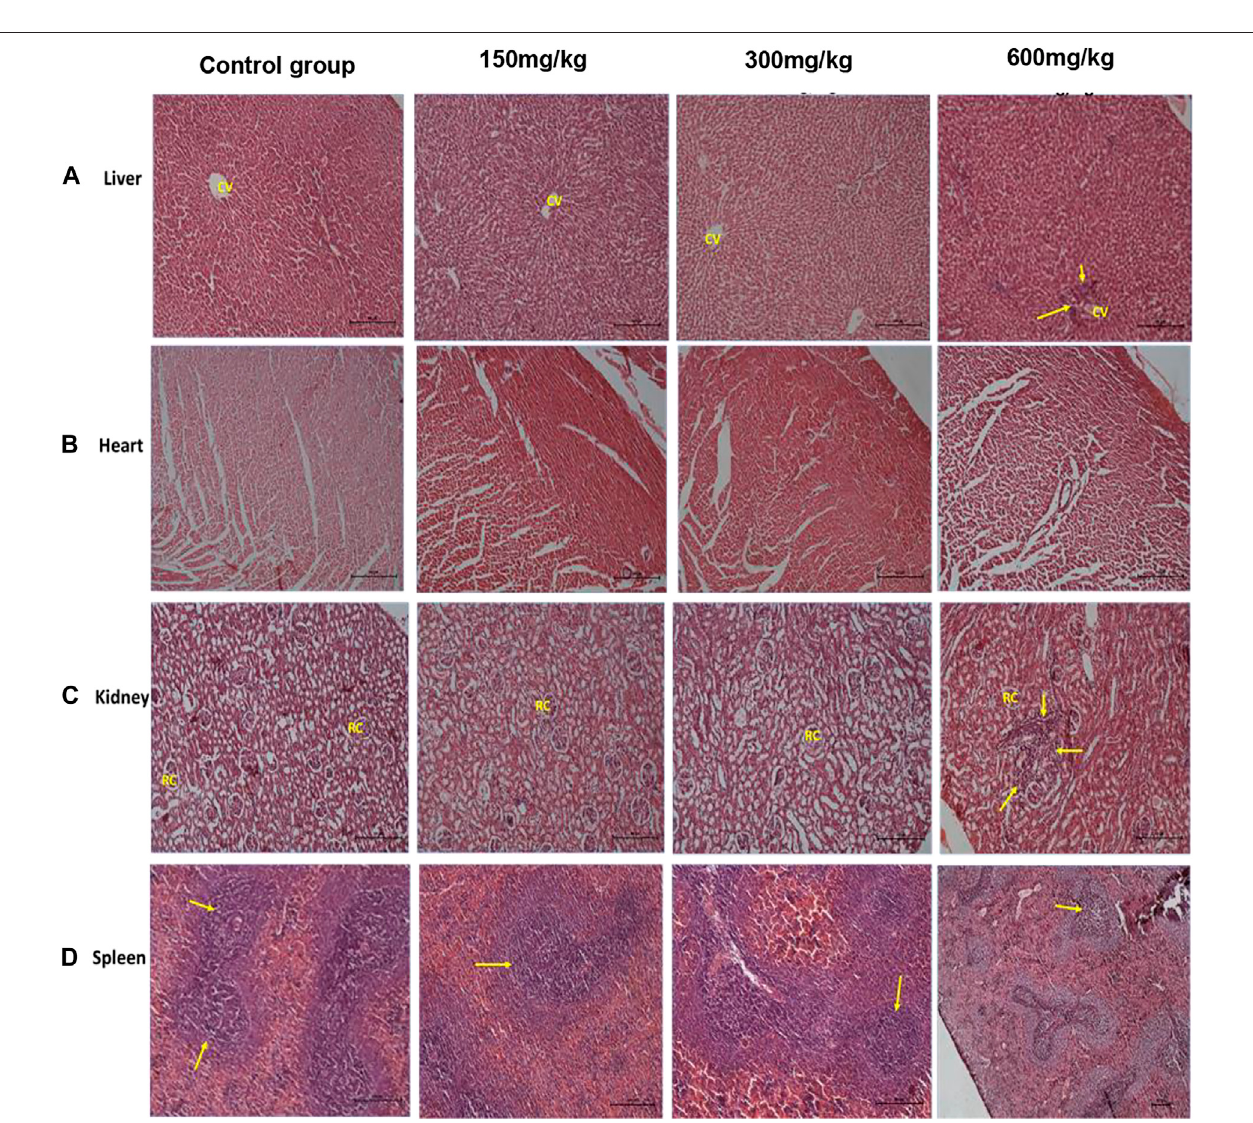
FIGURE1| H&Eratorgan sections. Panel (A) showsnormalliverarchitectureat lowerdoseswithclear central vain, at 600 mg/kg, cellularin fi ltration isseen(arrow heads). Panel (B) shows normal heart section with clear cardiac fi bers. Panel (C) shows normal kidney architecture at lower doses with clear renal capsules, at 600 mg/kg focal interstitial nephritis is seen (arrow heads). Panel (D) shows spleen white pulp hyperplasia due to non-speci fi c immunostimulation at all levels (arrow heads). Each photomicrograph enlargement is 100 µm.